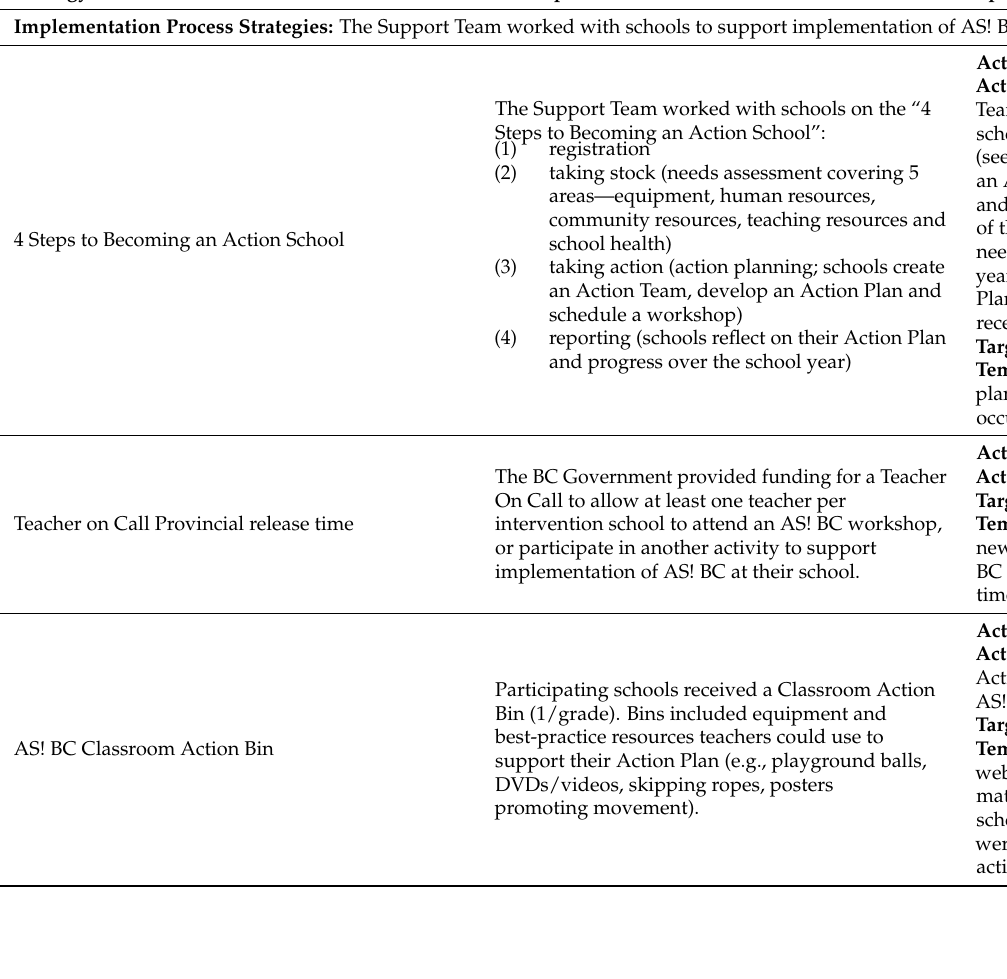
Table 2. Scale-up and implementation strategies fell into three categories: implementation process, capacity-building, and scale-up [40].